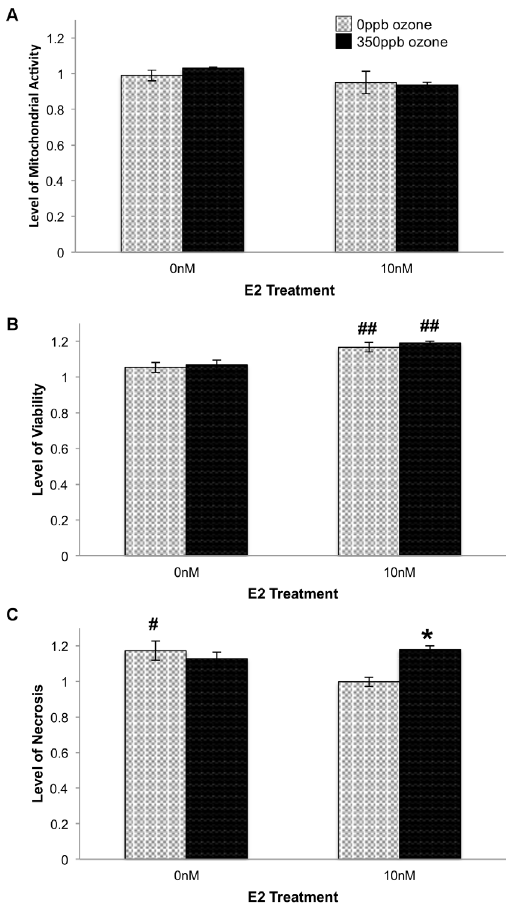
Figure 4. Effect of E2 and O 3 on relative levels of mitochondrial activity (A), viability (B) and necrosis (C) 24 hr after gas exposure. 10 4 L2 cells/well were treated with E2 and 350 ppb O 3 as indicated. After 24 hr, levels of mitochondrial activity (F=1.4122, df=3,15, p=0.2872), viability (F=7.2915, df=3,13, p=0.0071) and necrosis (F=5.9990, df=3,13, p=0.0132) were determined. Values represent the mean of 3–4 replicates normalized to data from control cells (-E2, in non-flowing 5% CO 2 /air), 6 S.E.M.* p # 0.05 in the same E2 treatment group. # p # 0.05 and ## p # 0.01 compared to the same O 3 exposure.